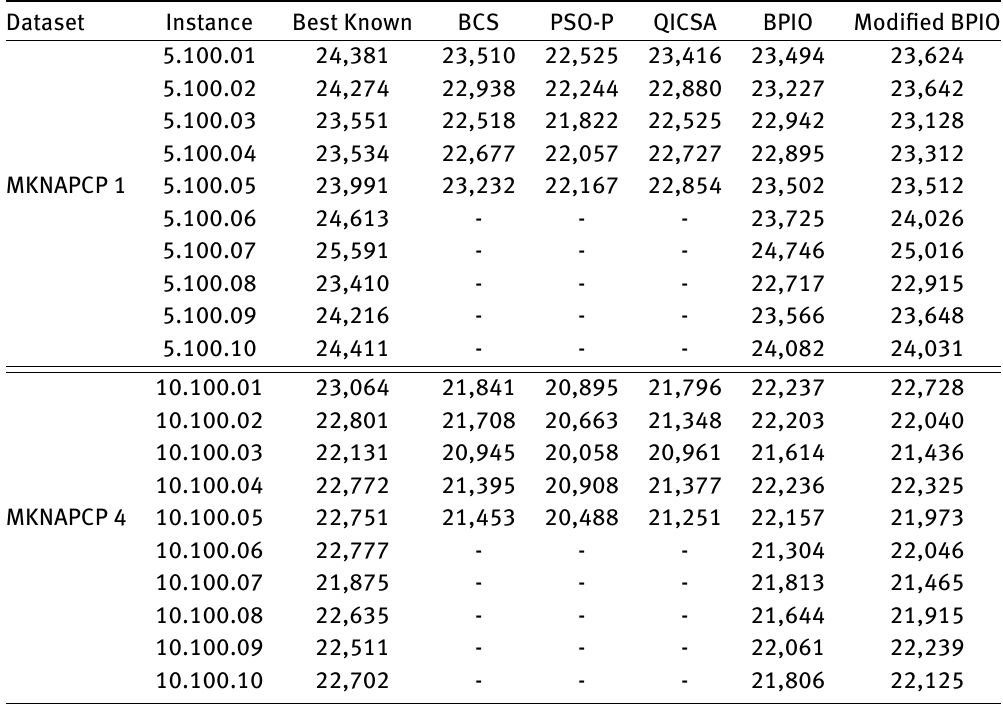
Table 9: The best results achieved by the Modified-BPIO and other comparative methods Dataset